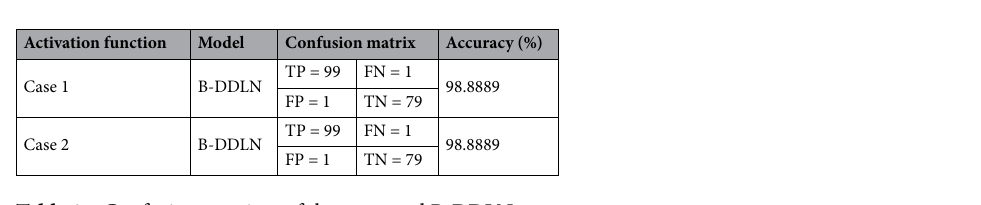
Table 2. Confusion matrices of the proposed